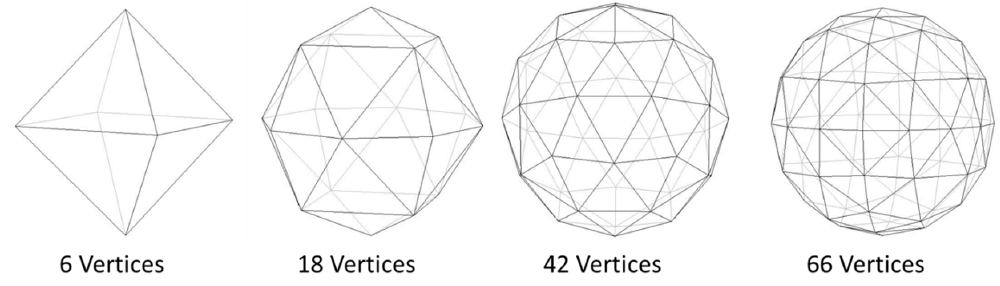
Figure 2. Regular convex polyhedrons that utilized in our method to take depth images of 3D models.